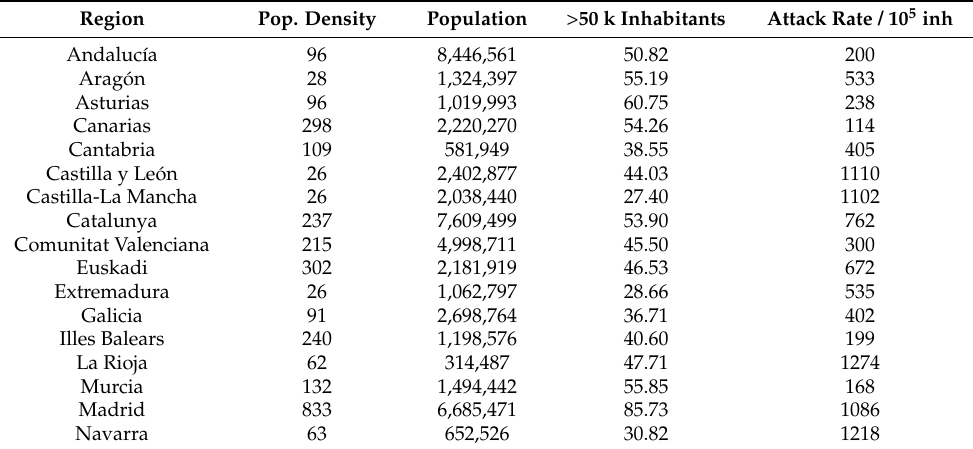
Table 1. Population density, population, percentage of population living in cities with more than 50,000 inhabitants and attack rate (total cases) of COVID-19 for the 17 Spanish regions on the first of July. Region Pop. Density Population > 50 k Inhabitants Attack Rate / 10 5 inh Andalucía 96 8,446,561 50.82 200 Aragón 28 1,324,397 55.19 533 Asturias 96 1,019,993 60.75 238